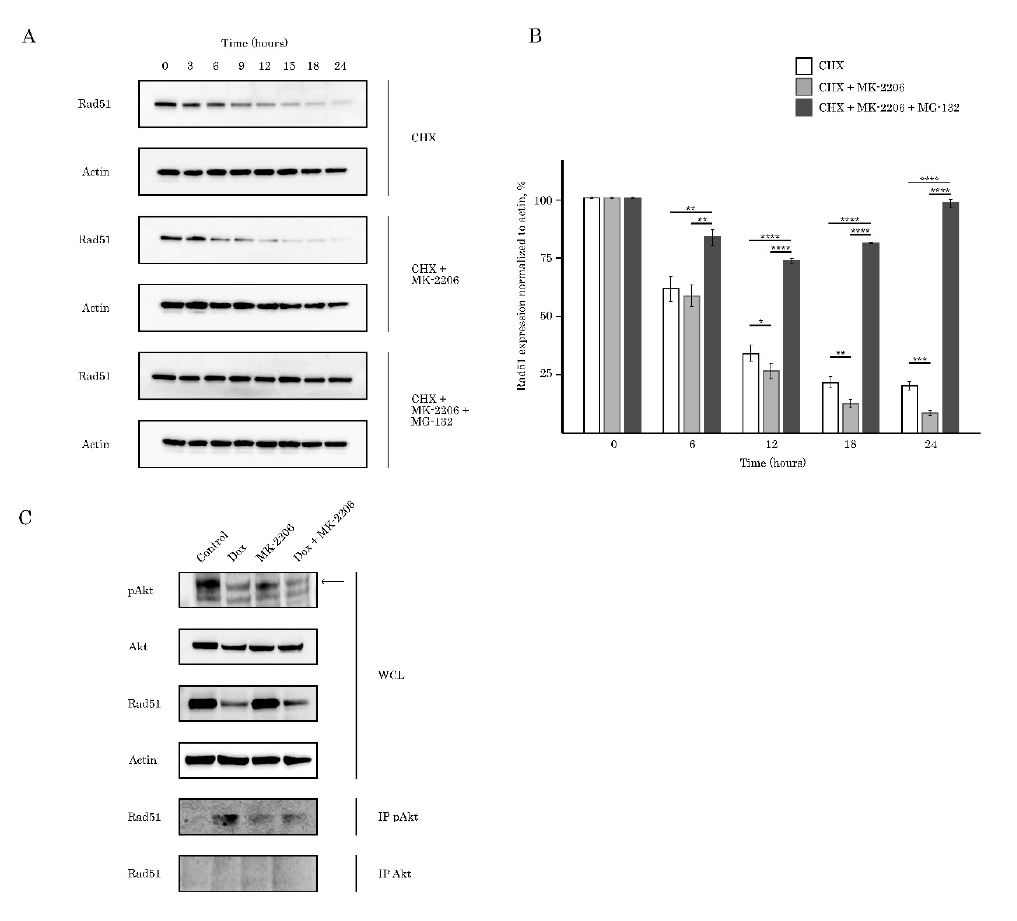
Rad51. Lysates from GIST T-1R cells were immunoprecipitated for Akt or pAkt Ser473, followed by